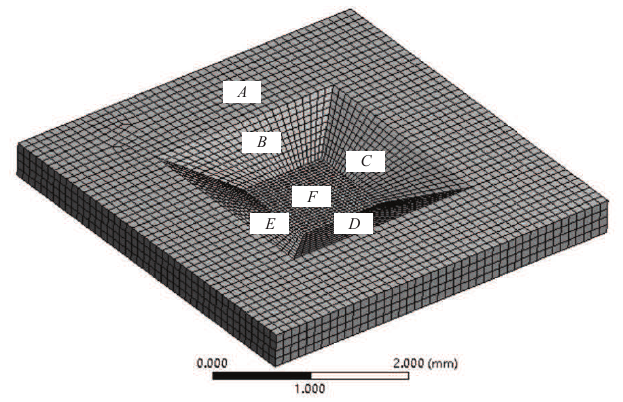
Figure 6. The model mesh of the silicon cup with load and constraint.